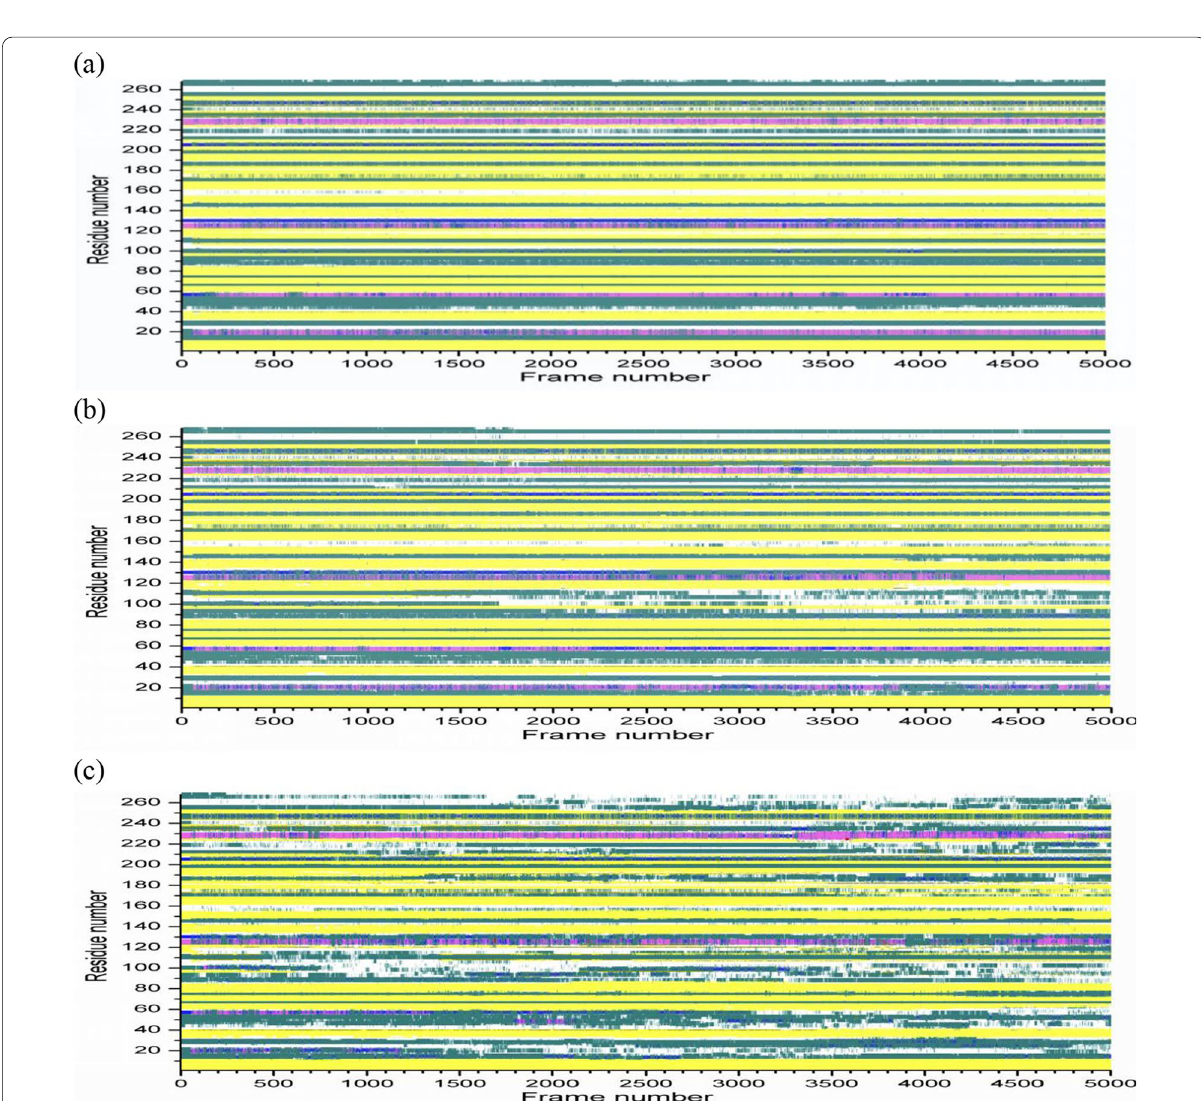
Fig. 4 Secondary structure variations of 1URX at different temperatures. A: 300 K; B: 400 K; C: 500 K. The x-axis shows frame number (trajectory number), the y-axis shows amino acid sequence number. Cyan, yellow, tan, purple, blue, red and white represent the secondary structure of T (Turn), E (β- sheet), B (Isolated bridge), H (Alpha helix), G (3–10 Helix), I (Pi-helix) and C (coil) respectively. Values have been calculated with the use